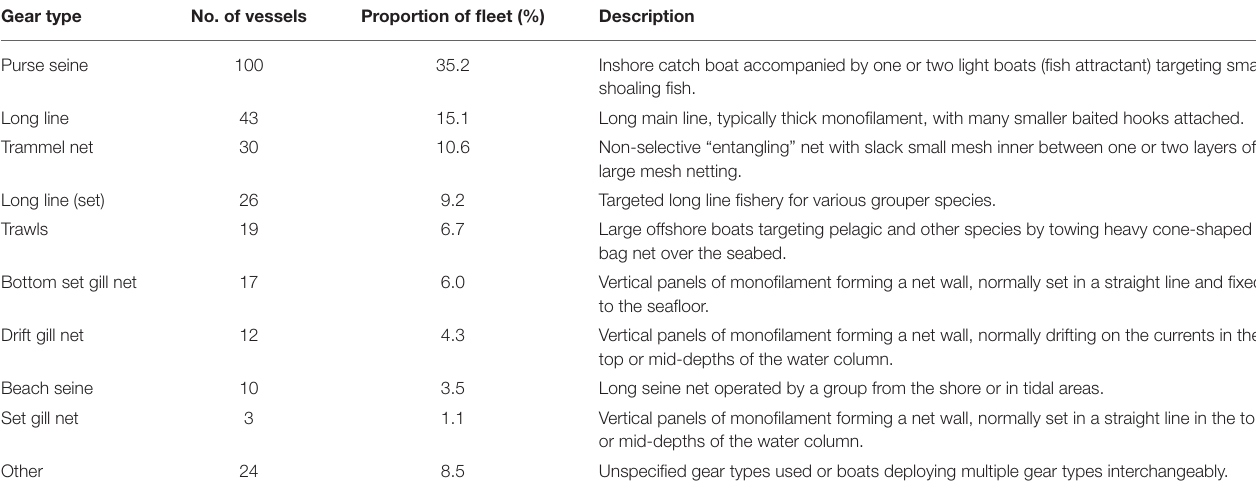
TABLE 1 | Fleet composition of Kyeintali sub-township landing sites surveyed in 2016 (Bicknell, 2019). Gear